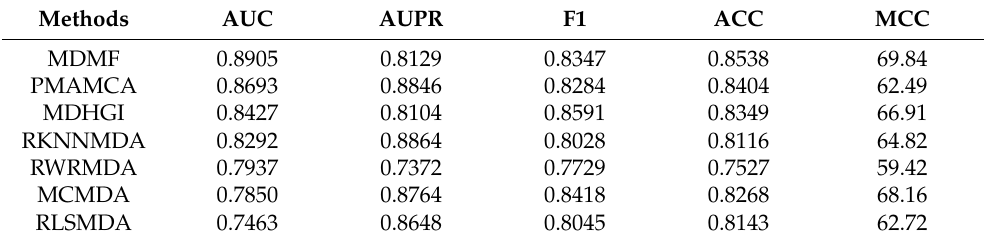
Table 3. Performance comparison of MDMF with other methods (local LOOCV). Various experiments under the various evaluation metrics clearly demonstrated the comparable performance of